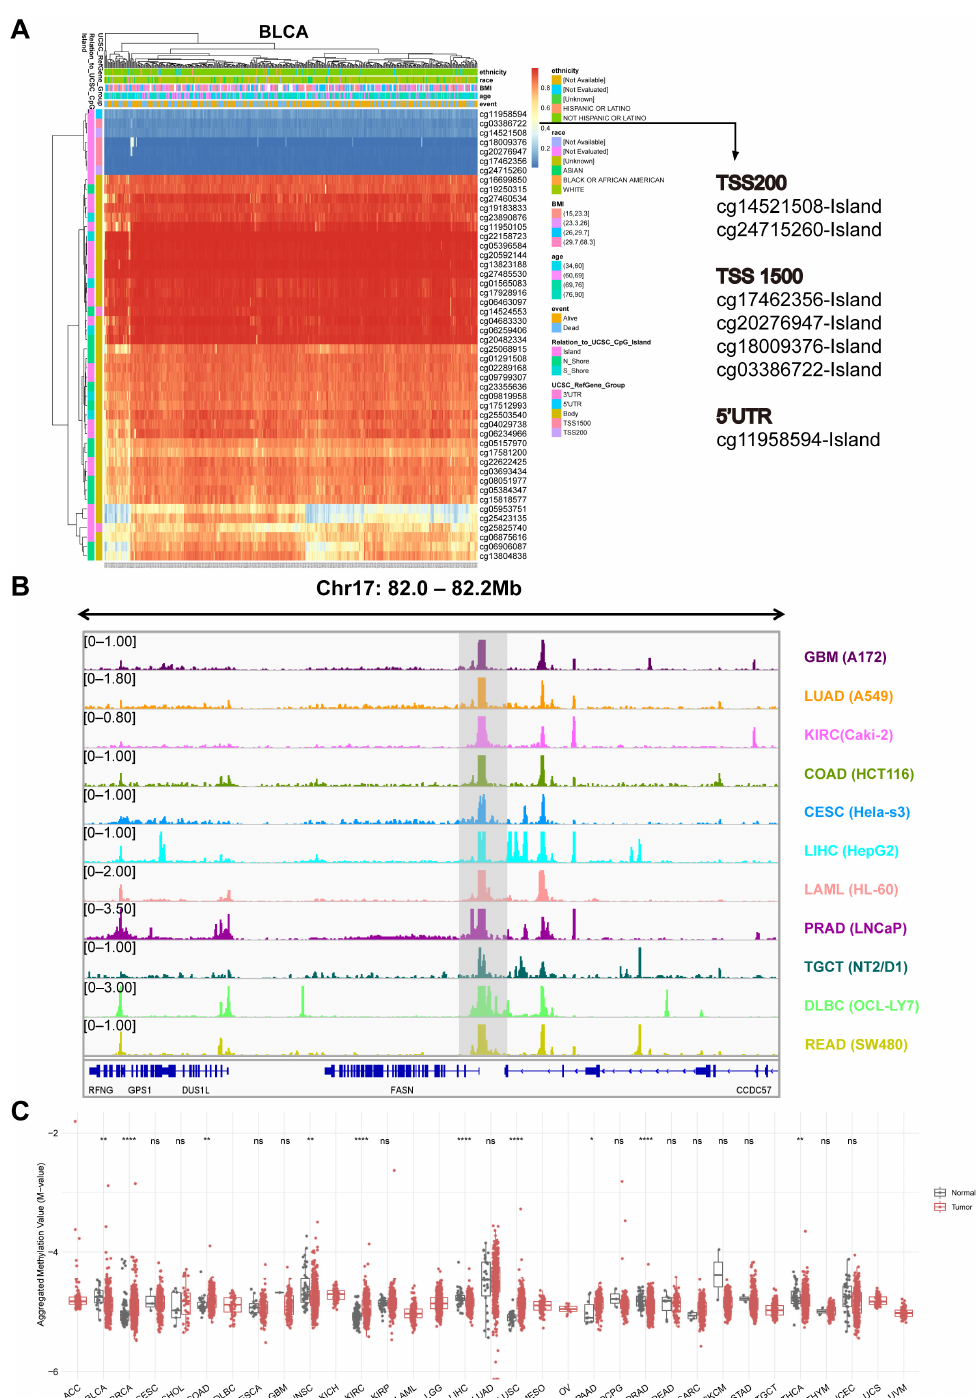
Figure 7. DNA methylation analysis of FASN promoter. ( A ) Distribution of DNA methylation at the FASN locus in the representative cancer BLCA. ( B ) DNase-seq data in eleven cancers obtained from the ENCODE database were visualized using the integrative genomics viewer, coordinates were located at the FASN locus, and the peaks of the target are shown in shaded areas. ( C ) Differences in aggregated methylation of seven methylation probes (cg24715260, cg14521508, cg17462356, cg20276947, cg18009376, cg03386722, cg11958594) of FASN in multiple cancers. (* p < 0.05, ** p < 0.01, **** p <